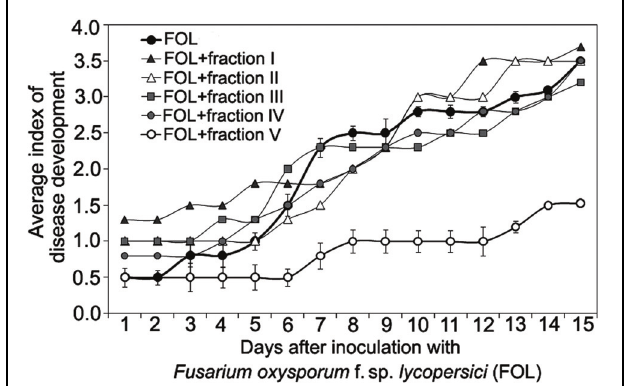
FIGURE 4 | Time course of Fusarium wilt on tomato seedlings treated with different fractions isolated by exclusion chromatography from high-molecular weight metabolites of a biocontrol F. oxysporum CS-20. Prior to inoculation by pathogenic FOL strains (F37 + Fot3), roots of tomato seedlings were exposed to fractions I–V (see Figure 3 ) for 2 days. Control seedlings were exposed to sterile ddH 2 0. The fractions were sterilized by passing through a microporous filter. After 2 days of incubation under aseptic conditions, seedlings were planted, and disease symptoms were visually monitored. Mean values of the disease index from four independent experiments, five replications a treatment in each ones, are presented. Bars represent